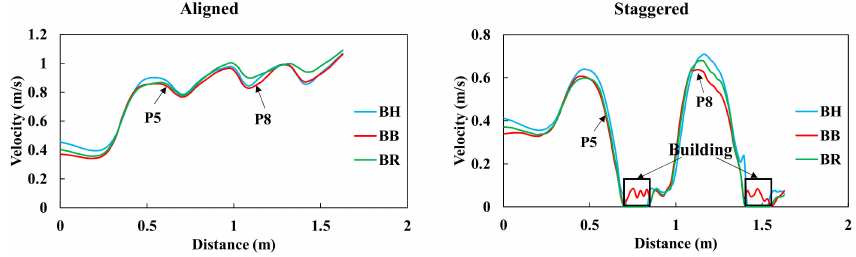
Figure 12. Simulated velocity profiles at 15